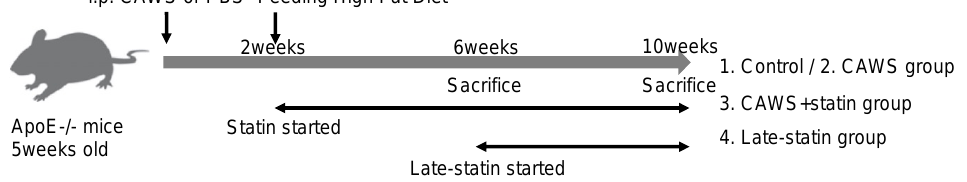
Figure 1. Experimental procedure. CAWS (4 mg for 5 consecutive days; control group received PBS instead) was injected intraperitoneally into 5-week-old Apo E-/- mice to induce KD-like vasculitis (the control group received phosphate-buffered saline instead). After 2 weeks of CAWS administration, the diet of all mice was changed to a high-fat diet to promote atherosclerosis. Mice were divided into four groups: 1. control group, 2. CAWS group, 3. CAWS+statin group, and 4. late-statin group. Statins (10 mg/kg/day) were dissolved in 0.5 mL of 0.5% Methylcellulose solution and then administered orally with a sonde. The control group was administered methylcellulose solution without statin. The CAWS and CAWS+statin groups received statins daily from 2 weeks after CAWS administration to the end of the experiment. The Late-statin group received statins daily from 6 weeks after CAWS administration to the end of the experiment. After 6 and 10 weeks of CAWS administration, mice were sacrificed, and the samples were collected.